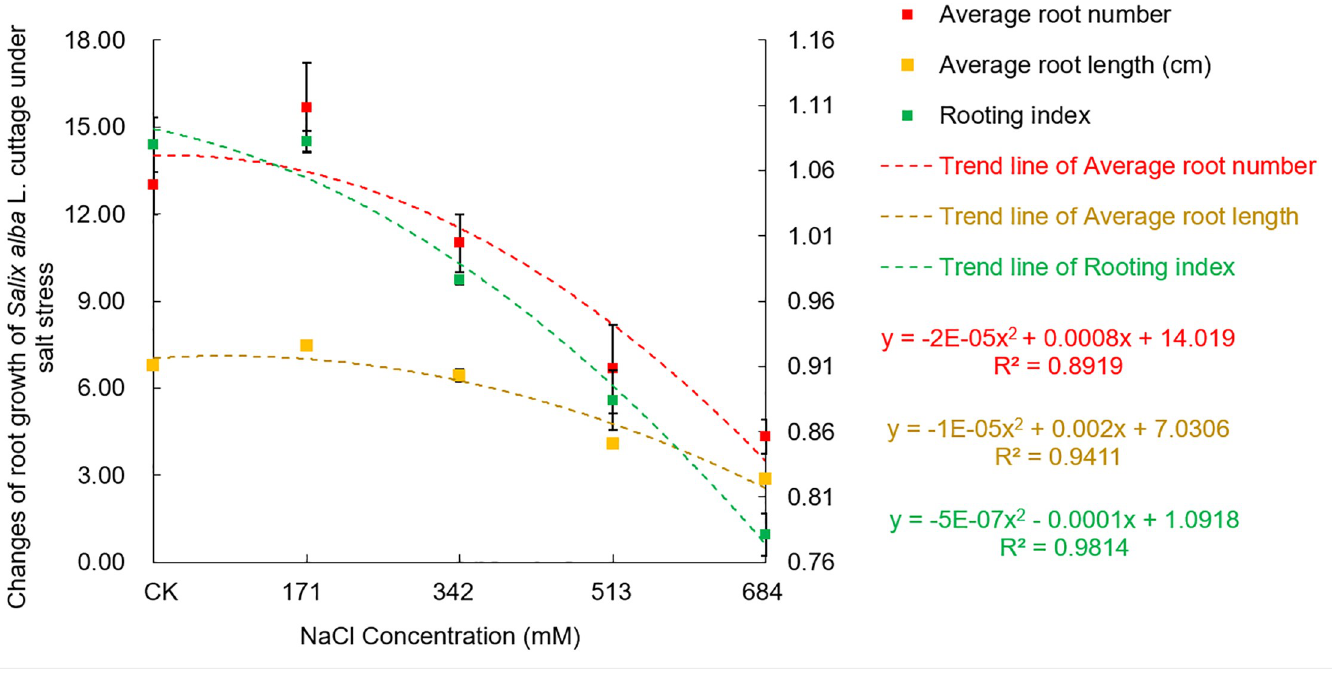
Fig 3. Effects of salt stress on root growth of Salix alba L.